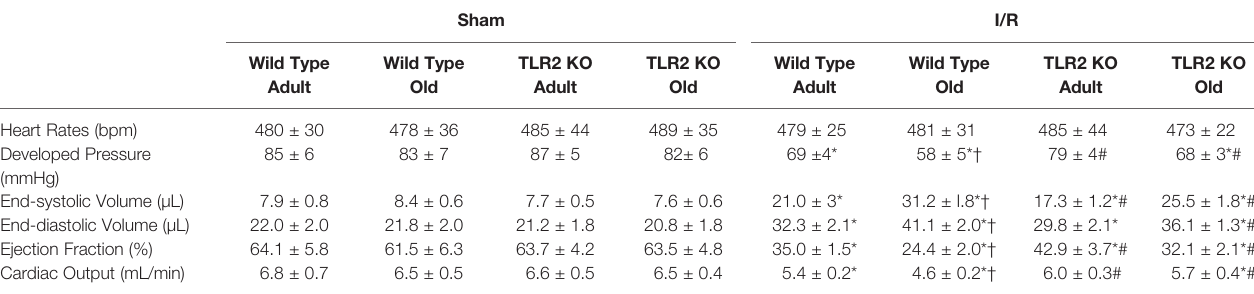
Mean ± SE; n=7 in each group. *P< 0.05 vs. respective sham; † P< 0.05 vs. C57BL/6 wild type adult; # P< 0.05 vs. wild type of the same age.